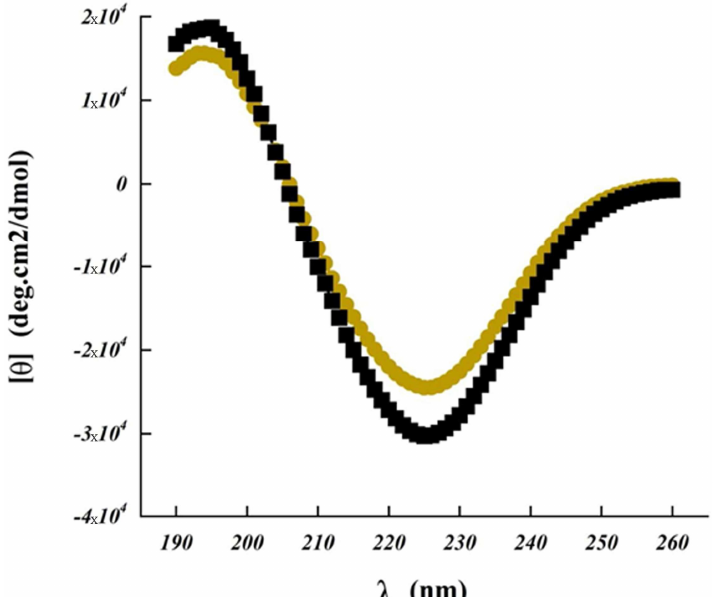
Figure 4. Far ultra-violet circular dichroism spectrum of cyclosporine (CsA) upon aqueous diluted solution with 55% of acetonitrile, and spherical amorphous solid dispersion based on Poly- αβ -CD polymer of CsA (SASD/CsA). Samples were measured in triplicate.